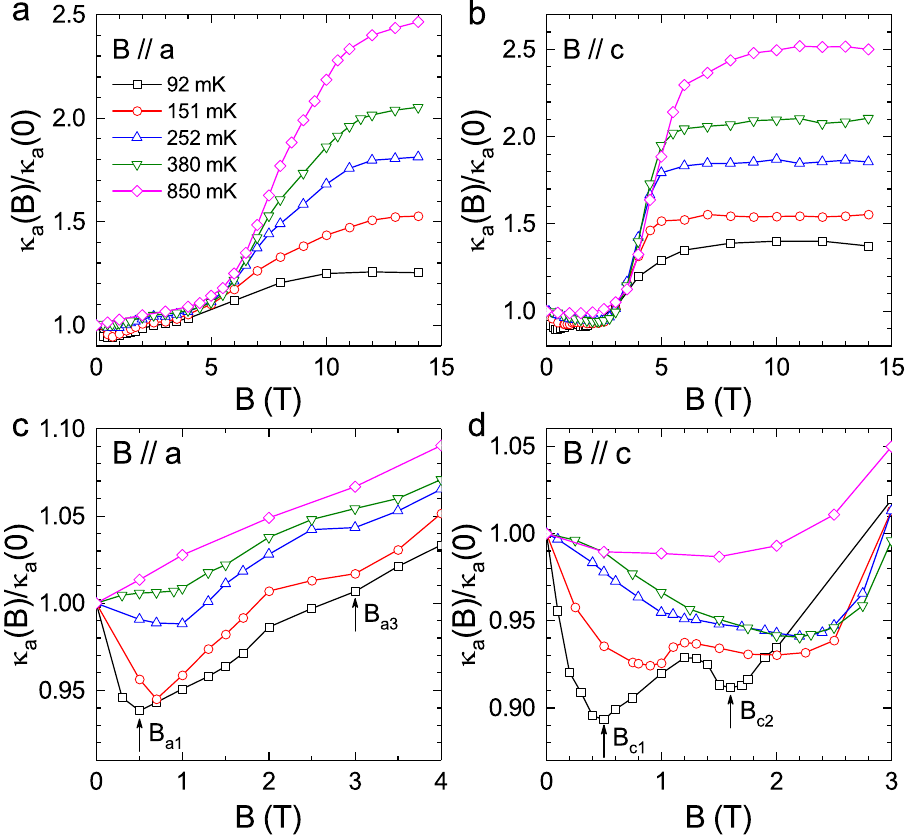
Fig. 2 Magnetic fi eld dependence of the a-axis thermal conductivity of YbMgGaO4. a , b Magnetic fi eld dependence of κ a at various temperatures with fi eld-applied along either the a- axis or the c- axis. c , d A magni fi ed view of κ B ) data at low fi elds. At 92 mK and with B // a , there is a minimum at 0.5 T a ( and a slope change at 3 T, indicated by arrows. While at 92 mK and with B // c , there are two minima at 0.5 and 1.6 T. With increasing temperature, these anomalous minima become weaker and disappear above 850